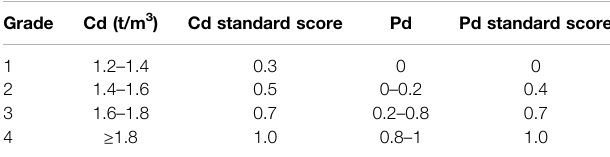
TABLE 2 | Classi fi cation of Cd and